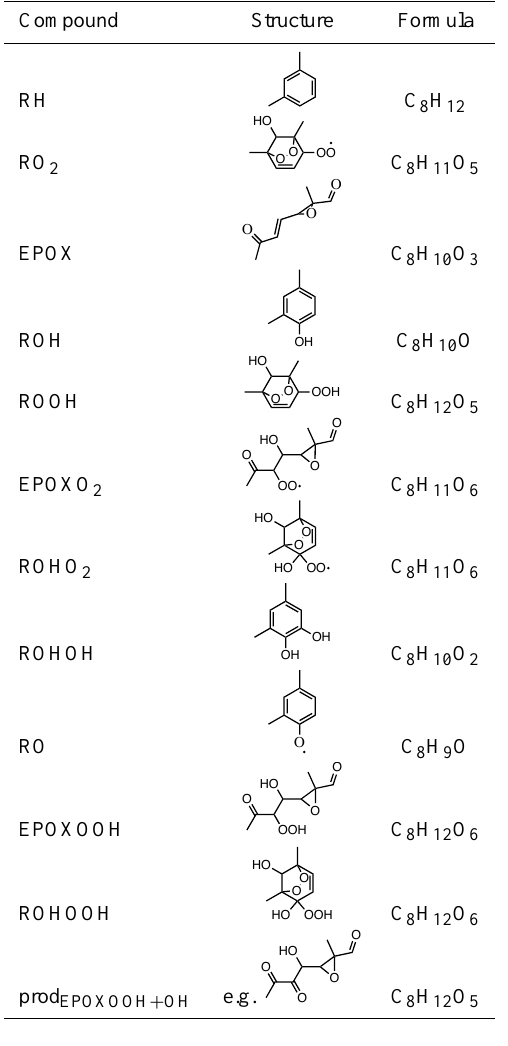
Three different pairs of organic and sulfate mass distribu- tions consistent with the measured number distribution and r OS were created from the suspended particle number dis- tribution averaged between hours 12 and 12.5 of irradiation from the combined 36 h aging experiment in order to deter- mine the uncertainty in the upper bound wall loss correction induced by size-dependent r OS (Fig. 12). The peak of the measured aerosol number distribution occurs at a D p smaller than that at which the wall loss rate is at its minimum, and the wall loss rate increases moving from lower D p to higher D p across the measured number distribution (not shown). Each of the distributions in Fig. 12 is characterized by the same total particle number distribution, an r OS of 2.00, and an or- ganic mass concentration of 22.7–22.8 µg m − 3 . Case I rep- resents condensation resulting from equilibrium gas-particle partitioning, and Case III represents condensation resulting from diffusion-limited growth. In Case II all particles have the same r OS . The aerosol size distribution was subjected to 24 h of wall loss at the rates applied to the experimental number distri- butions, ignoring condensation (growth and evaporation are assumed to cease) and coagulation. For each of the cases, r OS of the suspended particles and the upper bound wall-loss corrected mass concentration were calculated as a function of time (Fig. 13). In Case I, r OS of suspended particles in- creased by about 10 % over 24 h as particles with a lower r OS were preferentially lost to the walls. Because r OS of suspended particles is higher than that of deposited parti- cles, using r OS of suspended particles to represent